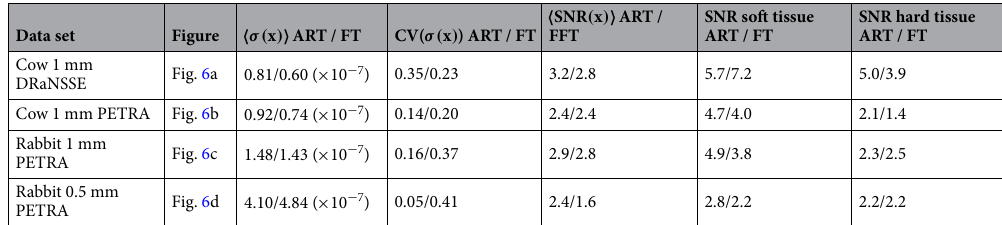
Table 2. Estimated noise and SNR parameters corresponding to images in Fig. 6. SNR in soft and hard tissue on Fig. 6c,d correspond to tongue and inner tooth, respectively. CV stands for coefficient of variation (the standard deviation divided by the mean) and (cid:31) . (cid:30) is the average operator.